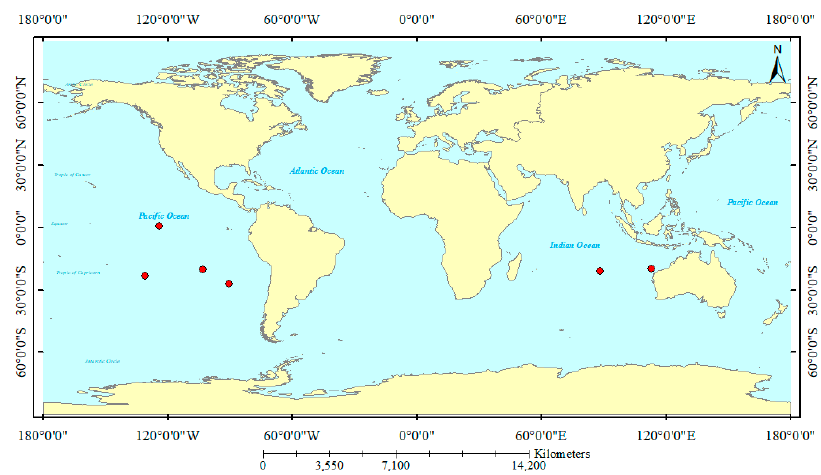
Figure 1. The location of the open ocean waters that were used as calibration sites in this study (red points).